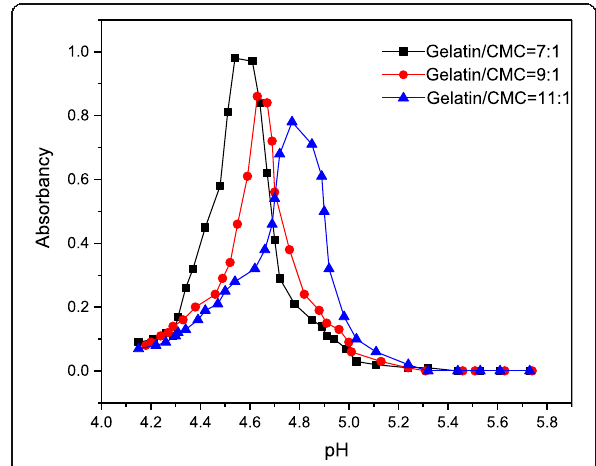
Fig. 1 Variation of absorbance of gelatin/CMC composite condensate with gelatin/CMC ratio and pH